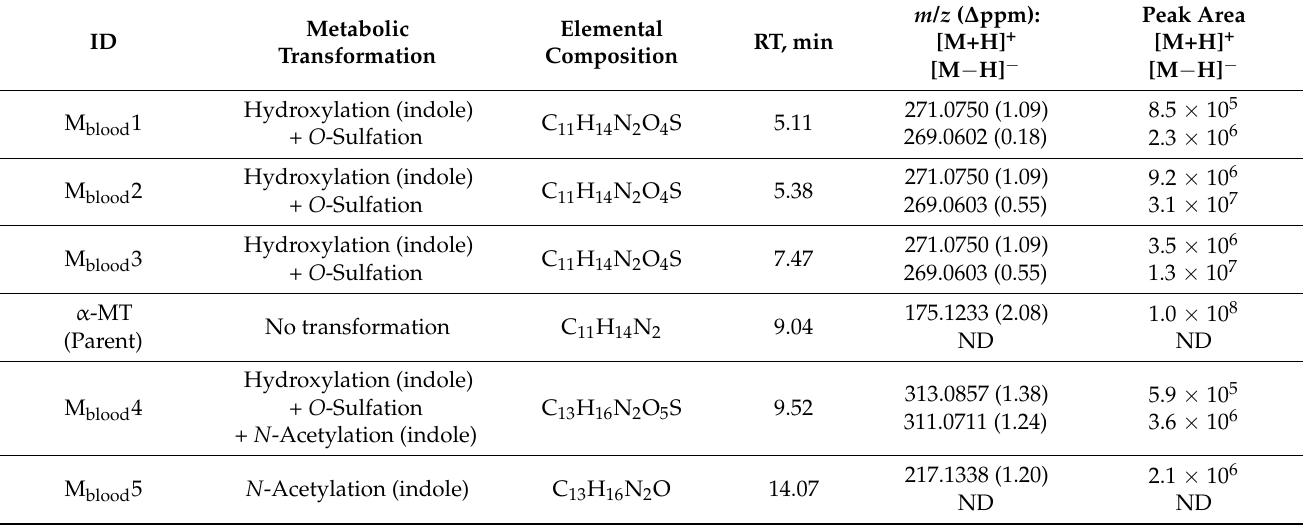
Table 3. Metabolic transformation, elemental composition, retention time (RT), accurate mass of molecular ion in positive- and negative-ionization modes ([M+H] + and [M − H] − , respectively) with mass error, and liquid chromatography–high-resolution mass spectrometry peak area of α -MT and metabolites in postmortem